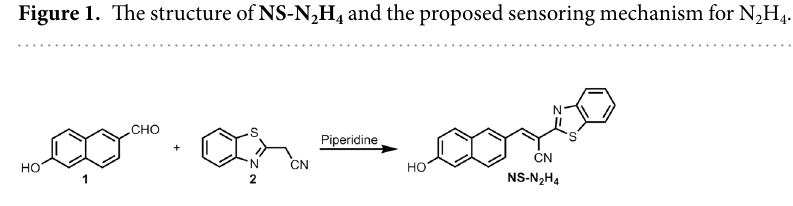
Figure 2. Synthesis of the two-photon fluorescent probe NS-N 2 H 4 .